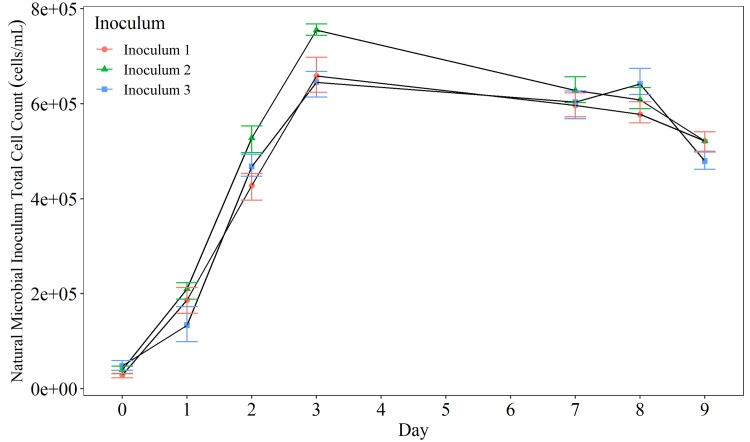
The effect of sample location on natural inoculum growth rate.The three inoculums were collected from three separate treated (post-treatment) water locations and prepared according to Hammes & Egli [21]. Inoculums were added to separate solutions containing 100 μg acetate carbon/L and incubated at 30°C for 9 days. Cell enumeration was via flow cytometry. The average (n = 3) cell counts (± standard deviation) are plotted.